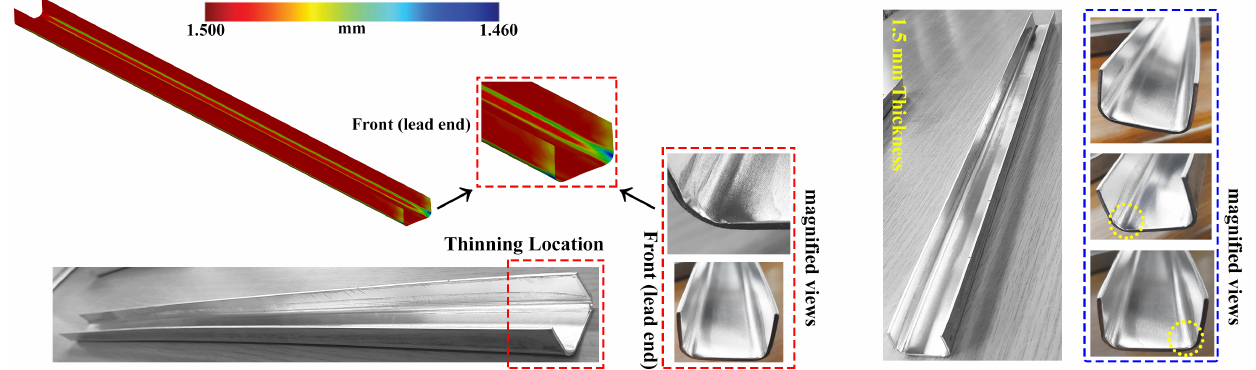
Figure 12. Thickness distribution in cold formed parts at 90mms − 1 forming